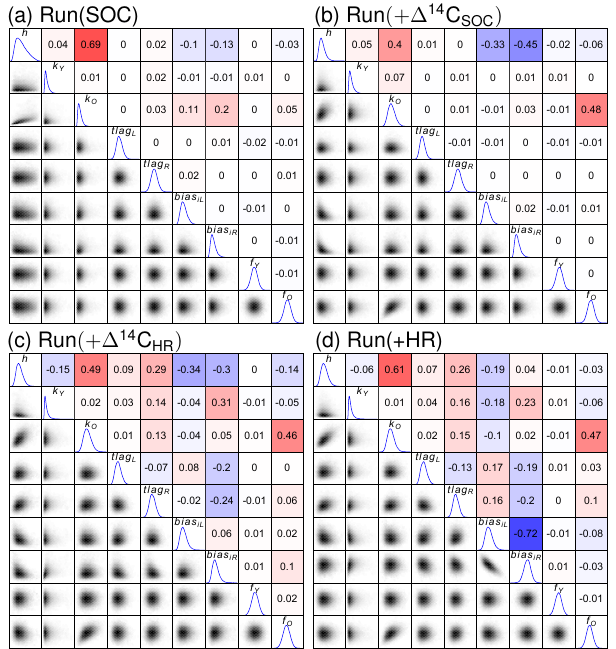
Fig. 5. Correlation matrices of the posterior parameter distributions for the four different calibration experiments (a–d). In the lower tri- angle of each panel, samples of the posterior parameter distribution of two parameters are plotted against each other (tick marks and la- bels were left out for clarity). The diagonal shows a kernel density estimate of the marginal posterior distribution. In the upper diagonal correlation coefficients between the parameters are shown. A gradi- ent from white to red indicates increasingly strong positive correla- tions, whereas a gradient from white to blue indicates increasingly strong negative